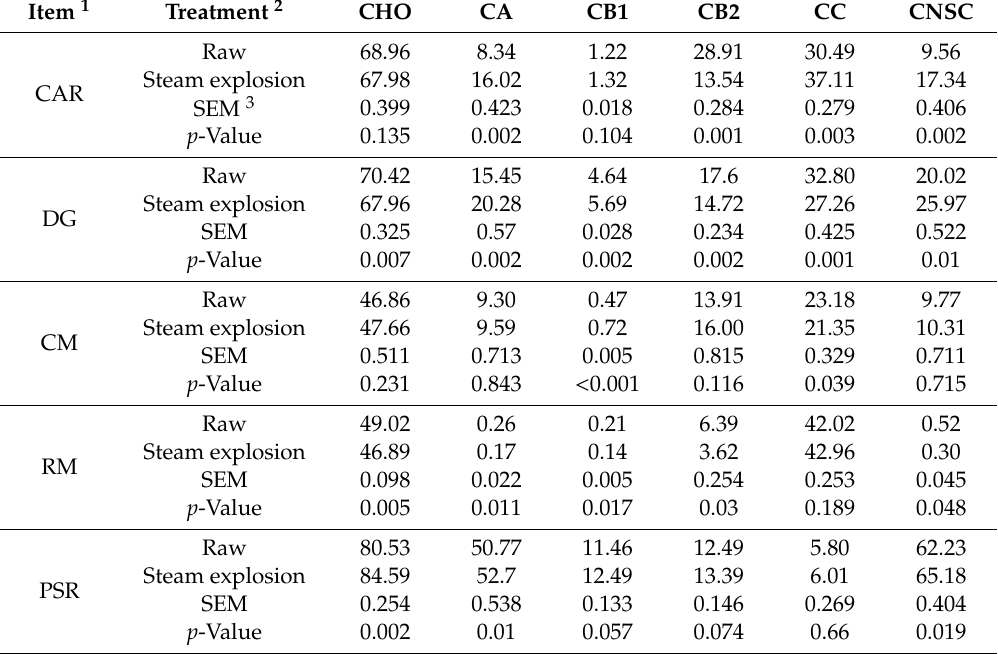
Table 3. E ff ect of steam explosion on the carbohydrate composition of five byproduct feedstu ff s (DM basis, expressed as